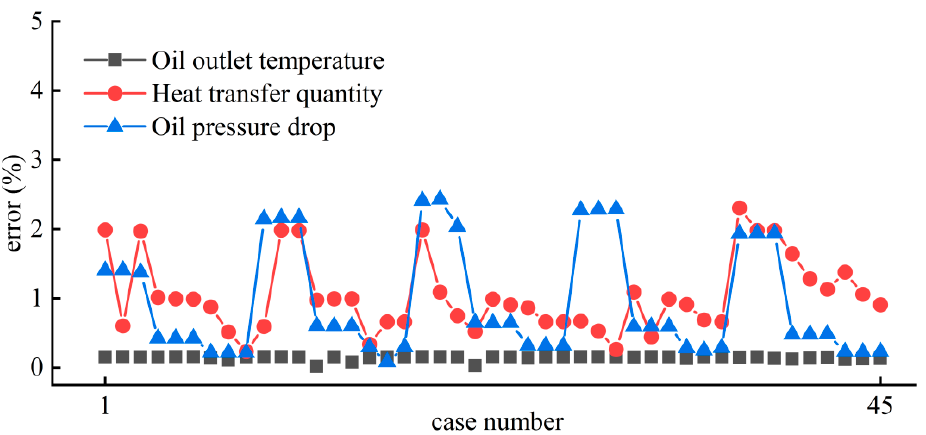
Figure 7. Percentage error of heat transfer quantity, oil pressure drop, and oil outlet temperature. NSGA-II is a genetic algorithm that can minimize or maximize two or more objective functions under given constraints and boundary conditions. The three objective functions selected in this study were heat transfer quantity, oil pressure drop, and oil outlet temper- ature. In the process of heat exchanger operation, the smaller the oil pressure drop, the smaller the oil outlet temperature, and the larger the heat transfer quantity, the better. In